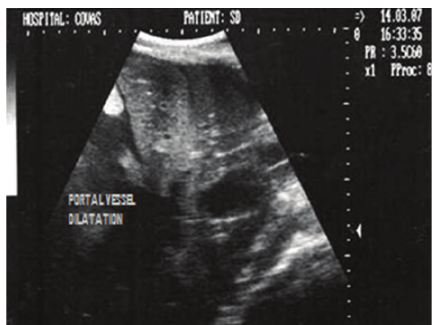
Figure 21: Longitudinal sonogram (2D) of liver depicting hypoe- choic parenchyma with marked portal vessel dilatation (subjective) in 5-year-old mixed-breed dog with significant